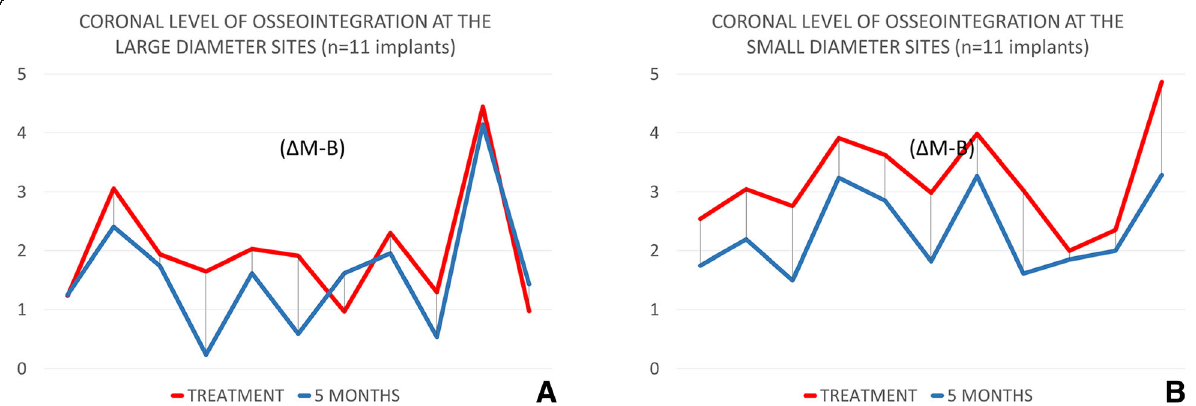
Fig. 5 Changes of the coronal level of osseointegration ( Δ M-B) evaluated for each implant. a Standard diameter group. b Narrow diameter group